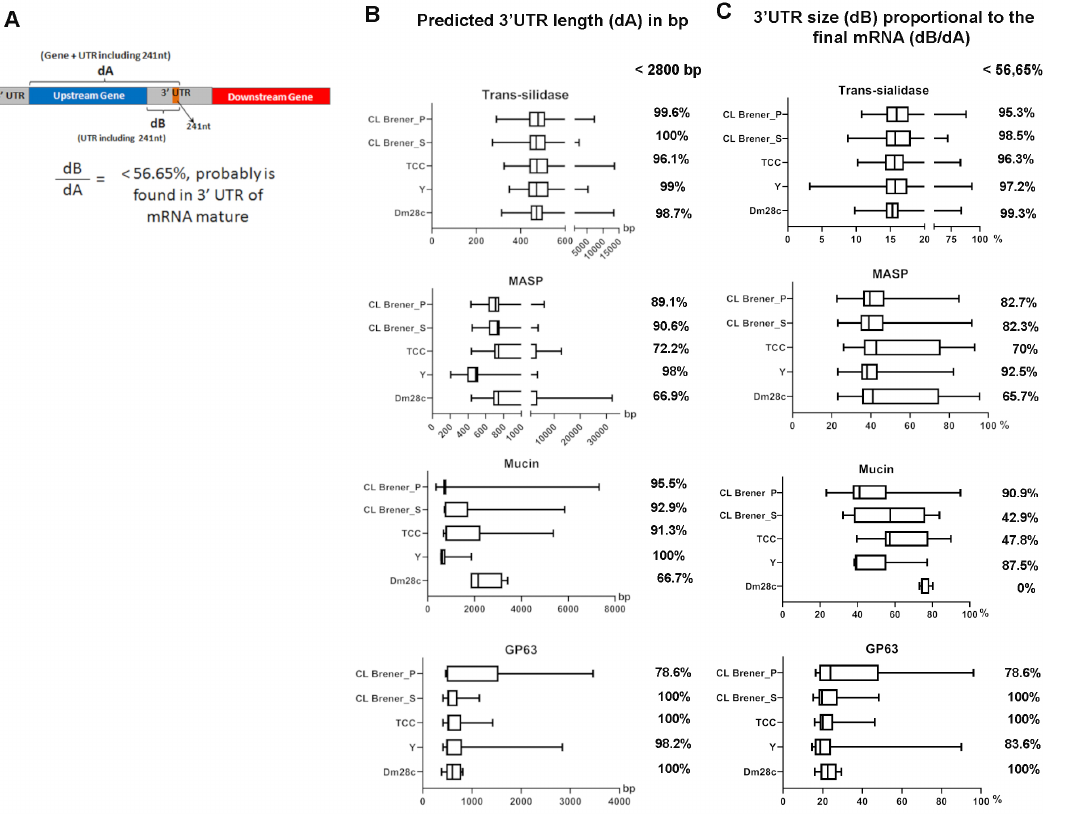
Figure 4. The 241 nt repeat is found in the 3 ′ UTR of upstream genes. ( A ) Schematic representation of upstream and downstream genes to the 241 nt sequence and distances used to predict the 3 ′ UTR length (dA). ( B ) Predicted 3 ′ UTR including the 241 nt sequence (distance dA is represented on “b”). The percentage of genes that predicted 3 ′ UTR represents less than 2800 bp of the mRNA and is listed on the left of the graphs. ( C ) The predicted 3 ′ UTR size (distance dB is represented on “b”, which includes the 241 nt sequence) in proportion to the final full mRNA was plotted. The percentage of genes that predicted 3 ′ UTR represents less than 56.65% of the mRNA is listed on the left of the graphs. In ( B ) and ( C ), the four major representative genes among upstream and downstream genes are represented. Abbreviations: MASP-mucin-associated surface protein and GP-glycoprotein. Over 96% of the trans-sialidase genes from DM28c, Y, TCC, and CL Brener showed a dB